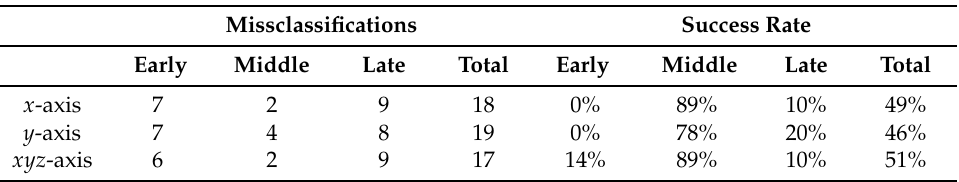
Table 2. Misclassification and success rate obtained in the functional supervised classification when applied to the data in the x -axis, y -axis and xyz